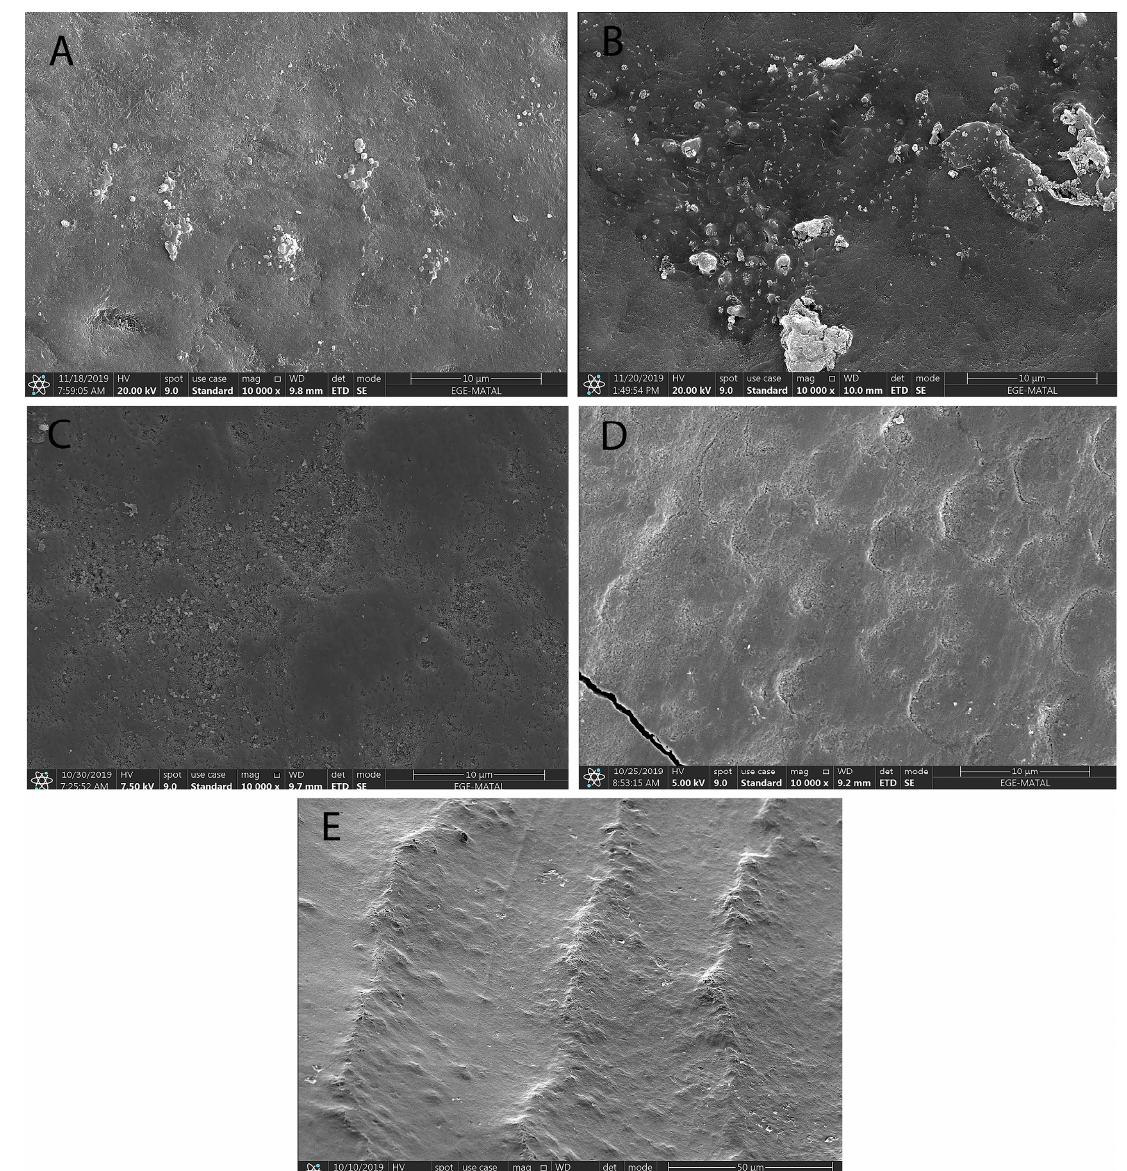
Figure 2. SEM images after 45 days. ( A ) Group 1: Bleached enamel surface treated with standard fluoridated toothpaste with bioglass (NovaMin). ( B ) Group 2: Bleached enamel surface treated with toothpaste containing calcium fluorosilicate glass. ( A , B ) precipitated layer of bioactive glass particles on the surfaces. ( C ) Group 3: Bleached enamel surface treated with standard fluoridated toothpaste. ( D ) Group 4: Bleached enamel surface with no toothpaste treatment showing some evidence of dissolved prism structures. ( E ) Group 5: Enamel surface with no treatment ( × 10,000 magnification).